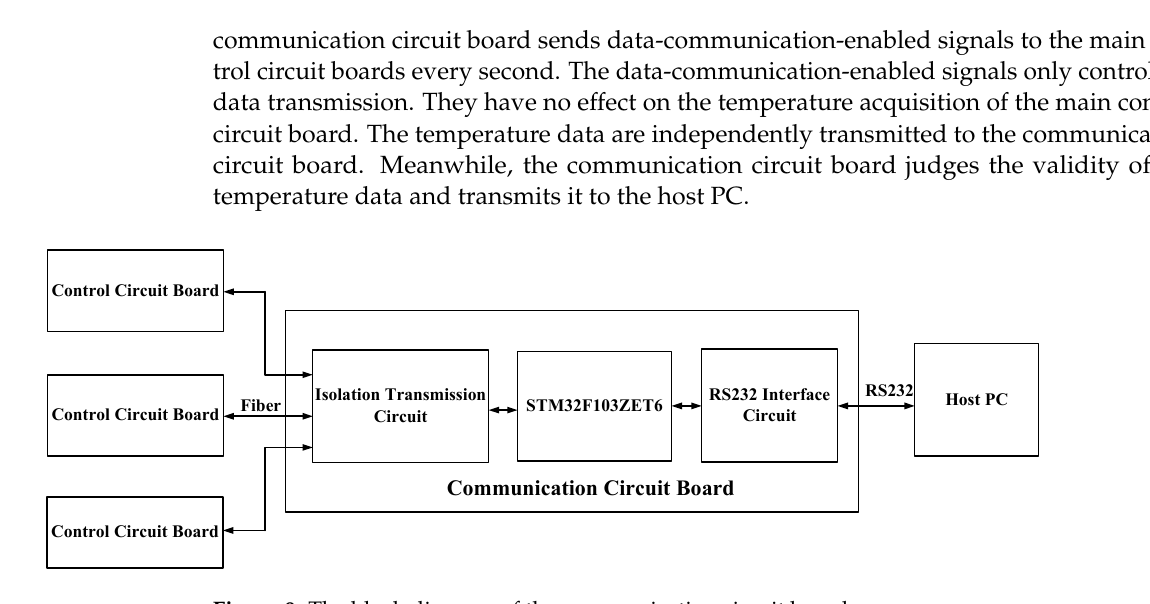
Figure 9. The block diagram of the communication circuit board.